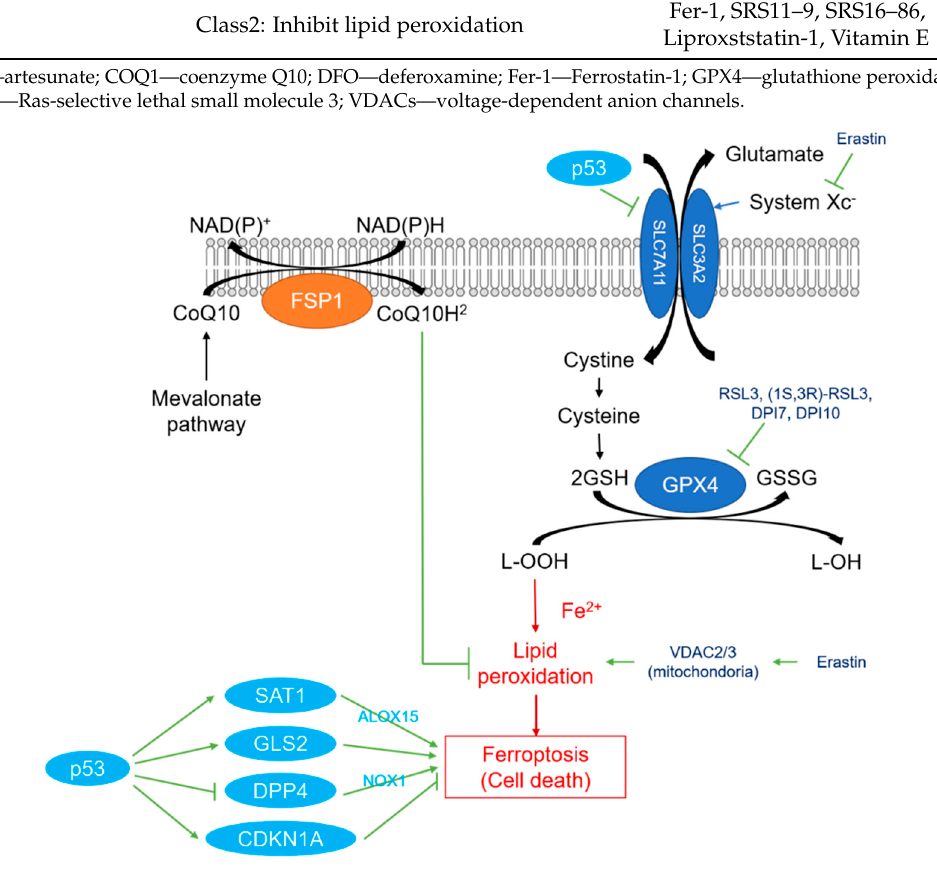
Table 2. The common inducers and inhibitors of ferroptosis.